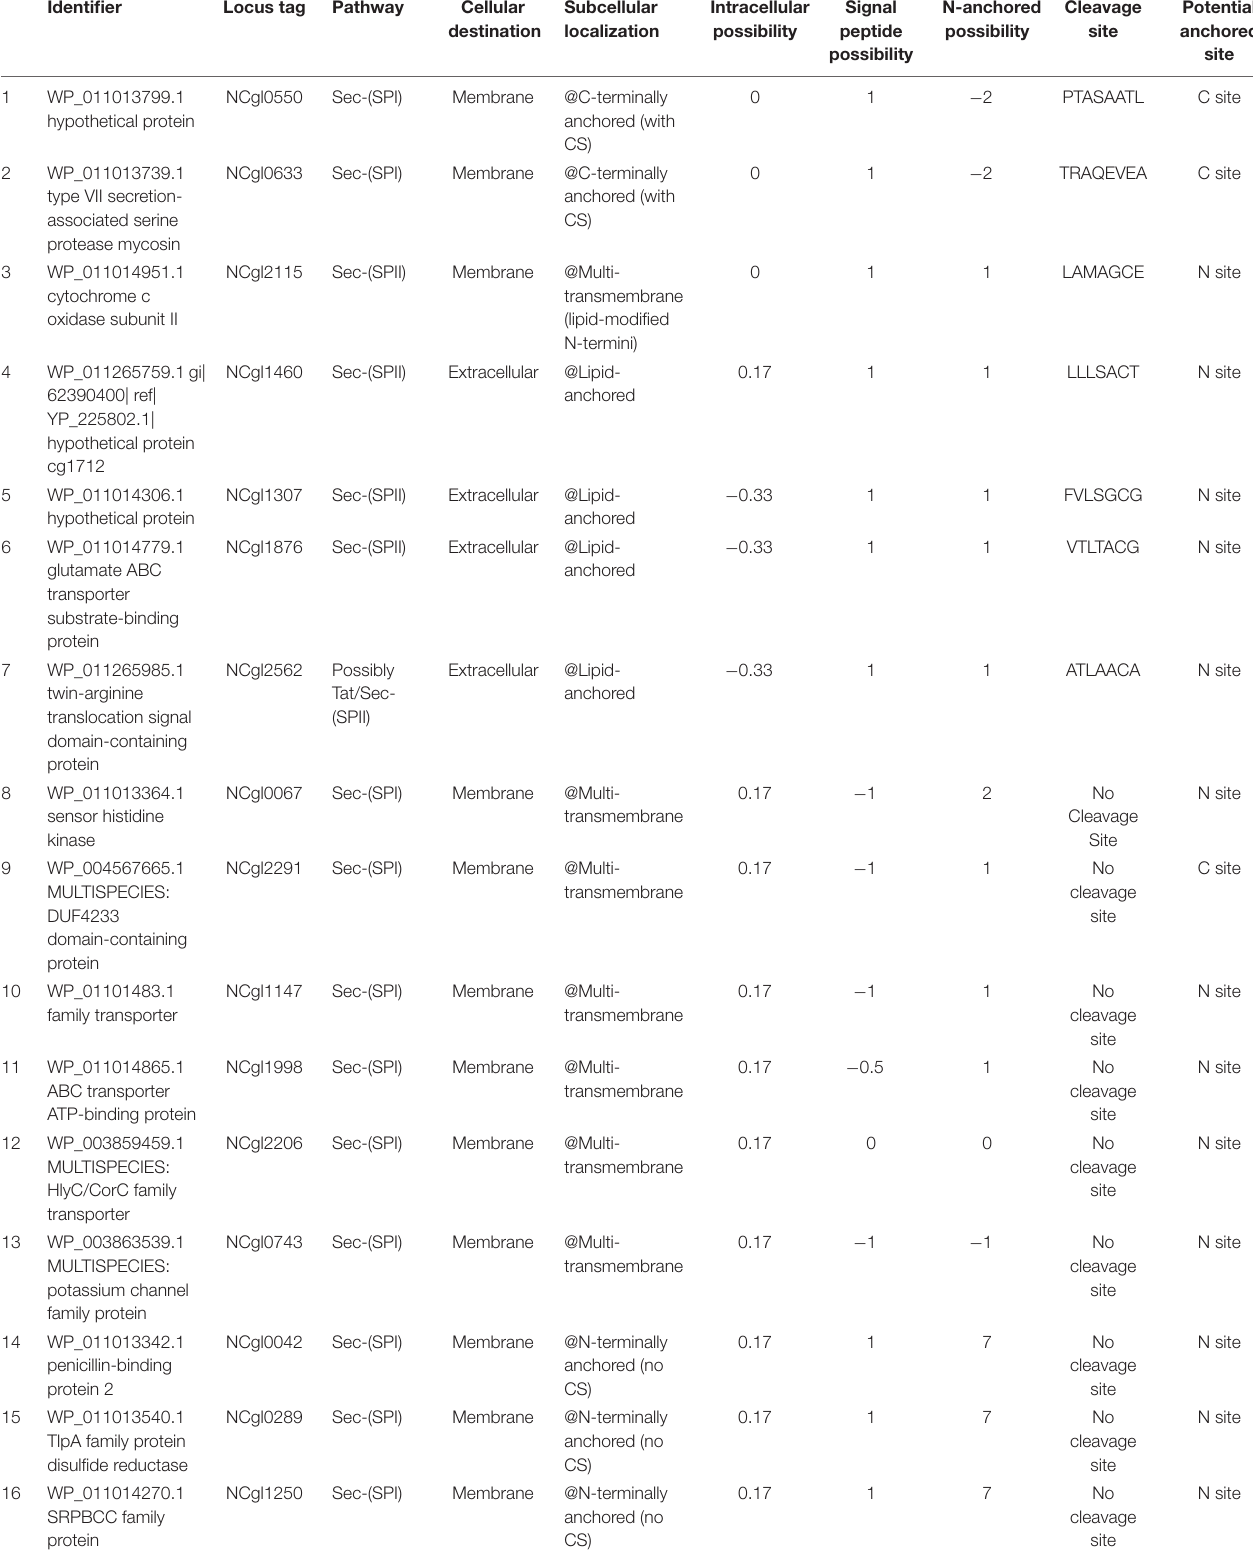
TABLE 3 | The 25 potential anchor proteins screened in this experiment based on the predicted results of LocateP and tied-mixture hidden Markov models.